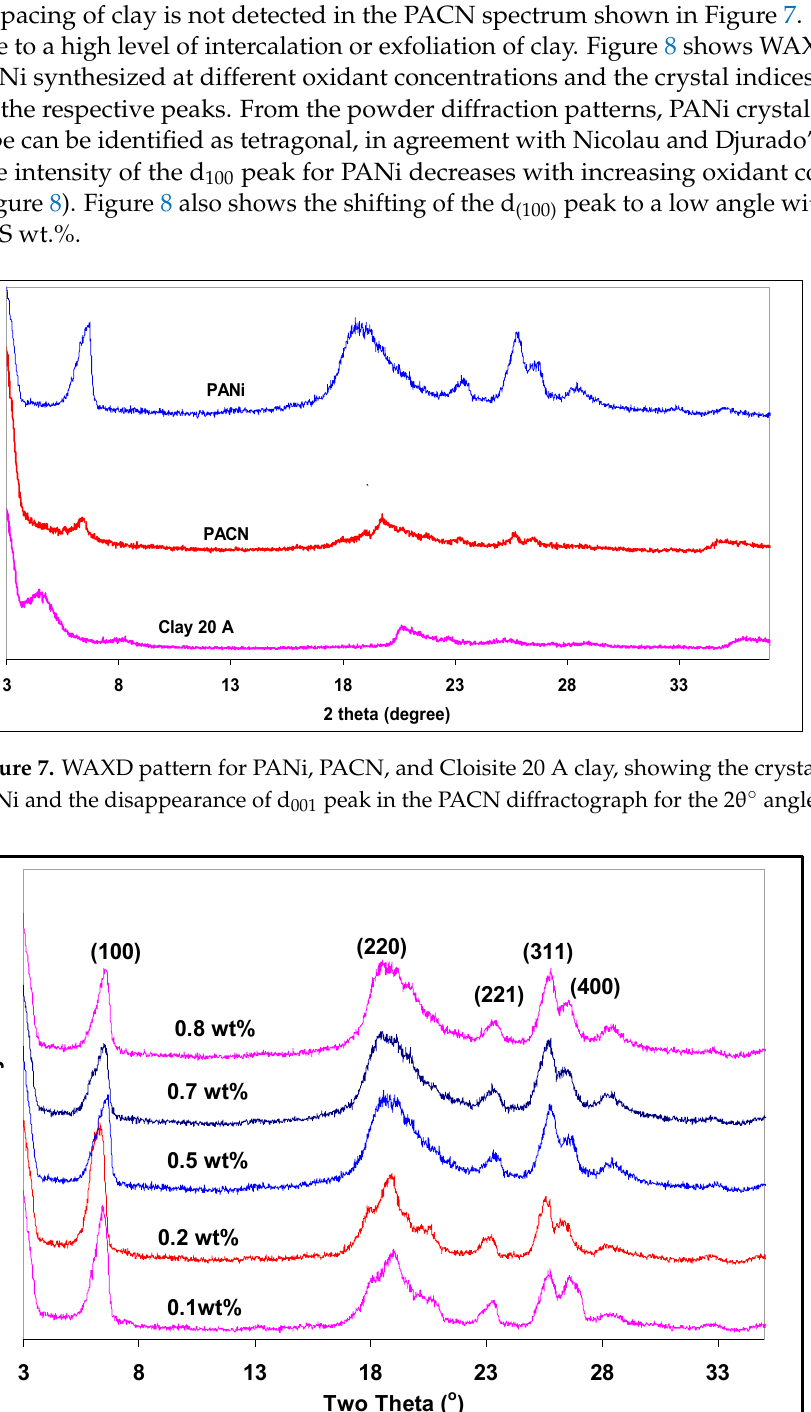
Figure 8. WAXD patterns for PANI formed as a function of APS concentration, showing decreasing intensity of PANi crystalline, d 100 peak, and shifting of same peak to lower 2 θ ° angle with increasing oxidant, APS, concentration.